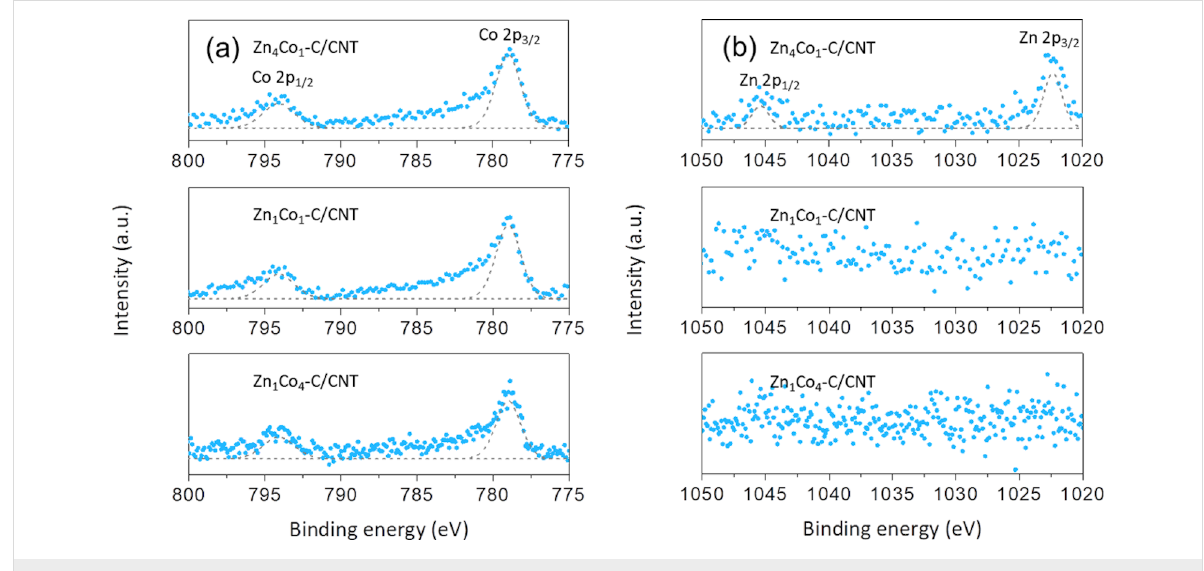
Figure 4: XPS spectra of Zn x Co y –C/CNT composites: (a) Co 2p and (b) Zn 2p.